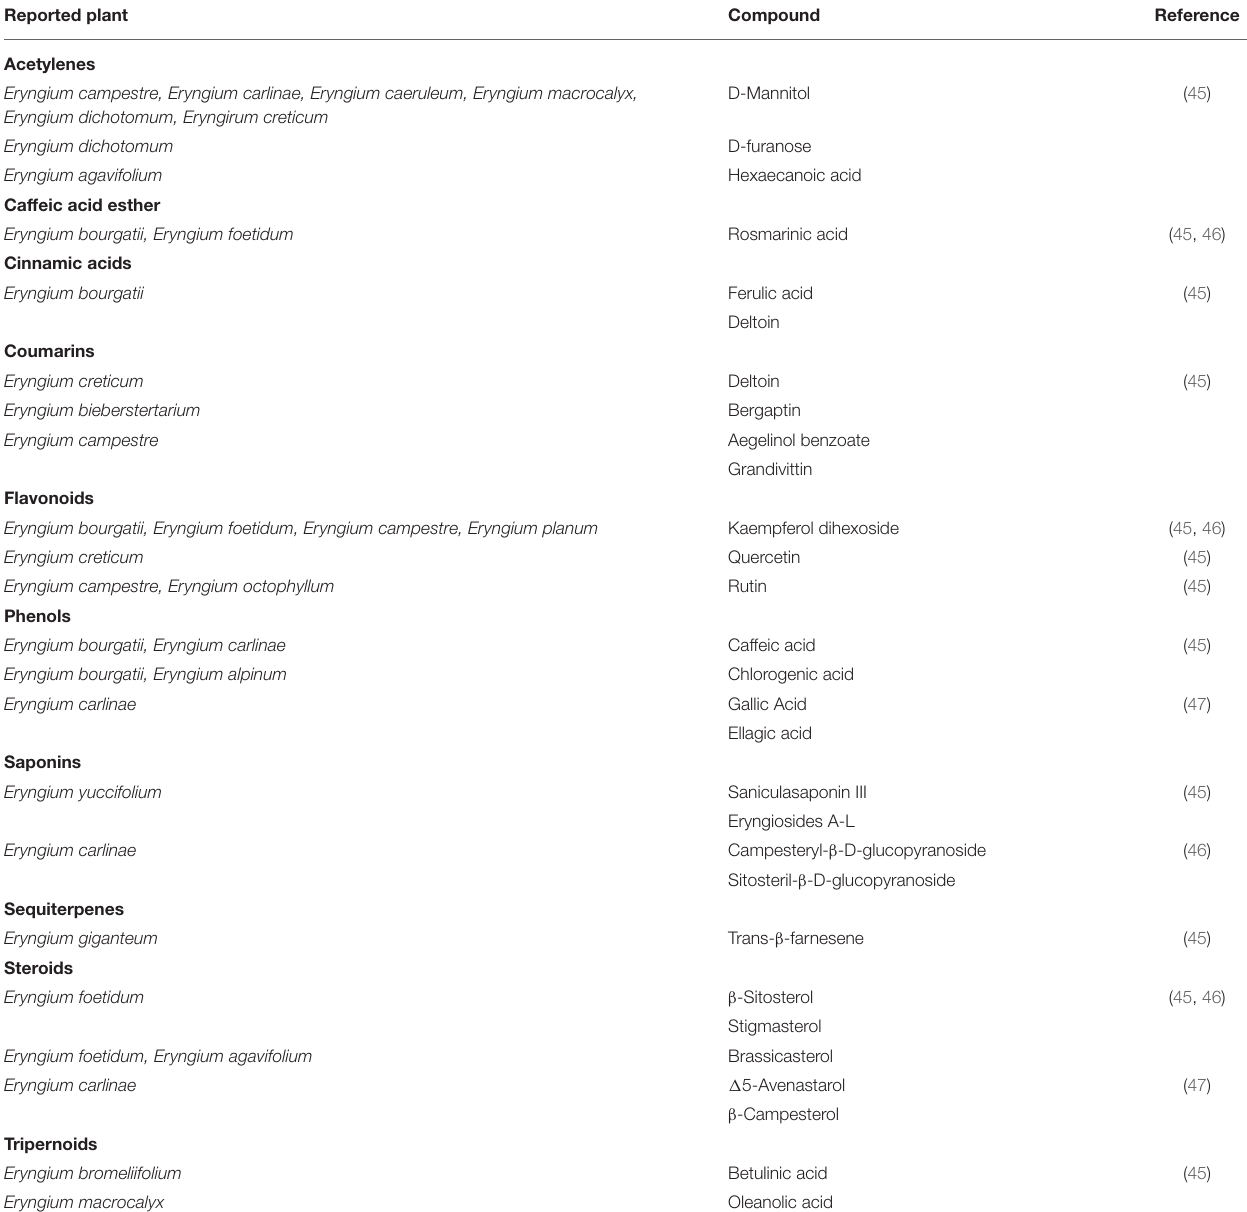
TABLE 1 | Phytochemical compounds found in aerial parts of Eryngium